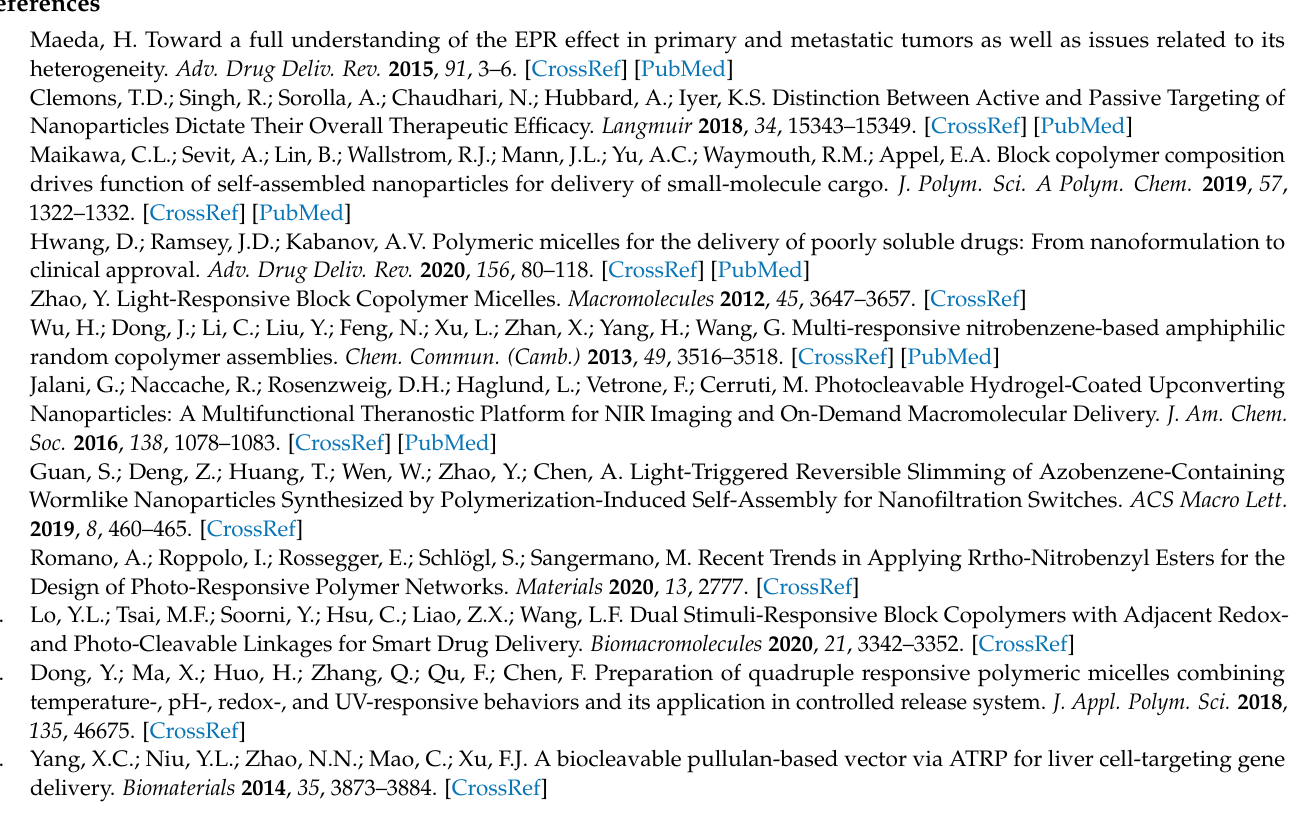
micelles; Figure S8: CMC of micelles; Figure S9: FTIR of MCP w/wo GSH; Figure S10: 1 H-NMR of MSP 50 upon UV light irradiation; Figure S11: UV-visible spectra of MSP 50 and MCP 50 upon UV light